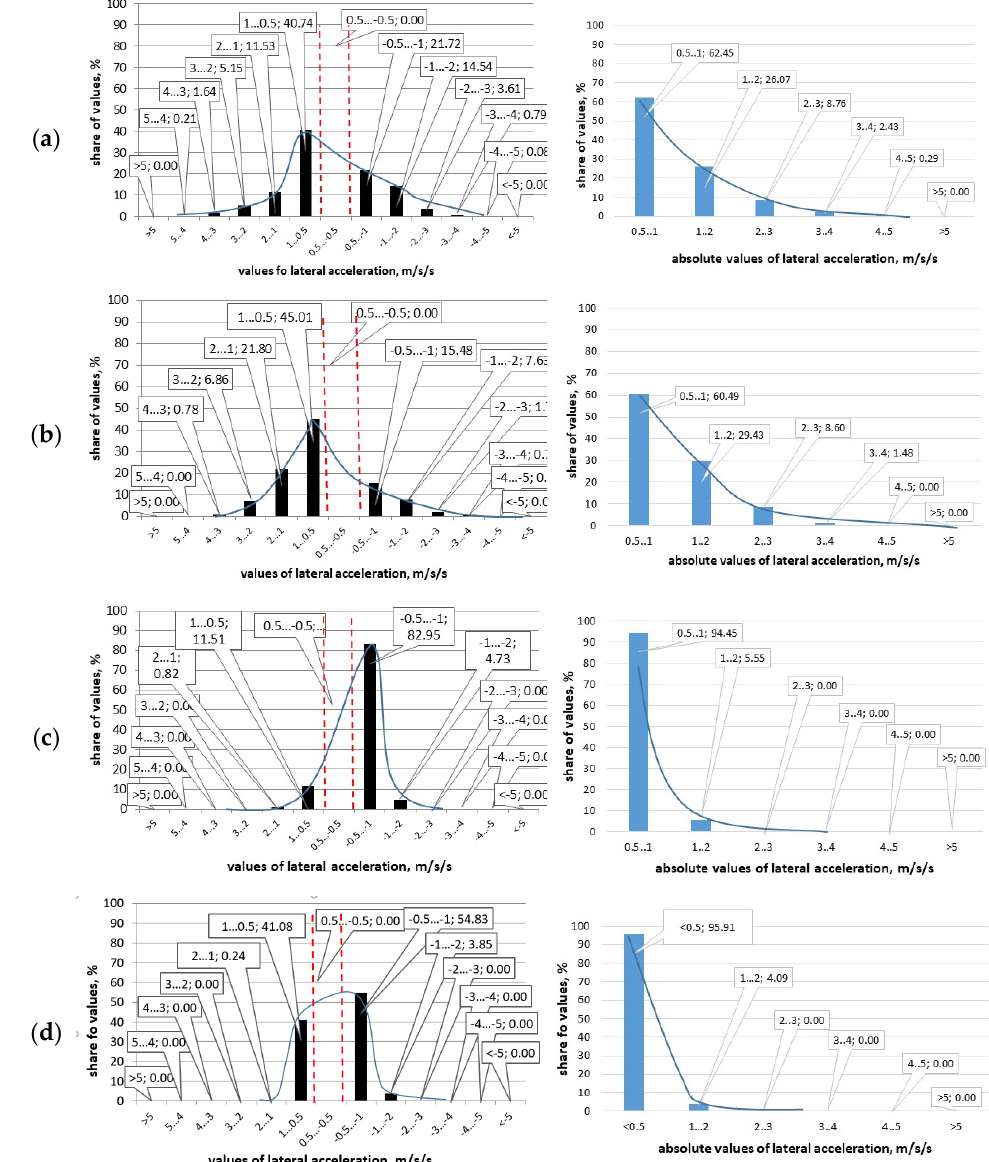
Figure 11. Lateral acceleration value ranges and their absolute values excluding the ‘constant speed’ driving range on various road types: ( a ) urban area (city); ( b ) non-urban area (single roadway with two traffic lanes); ( c ) two-roadway expressway; ( d ) motorway.